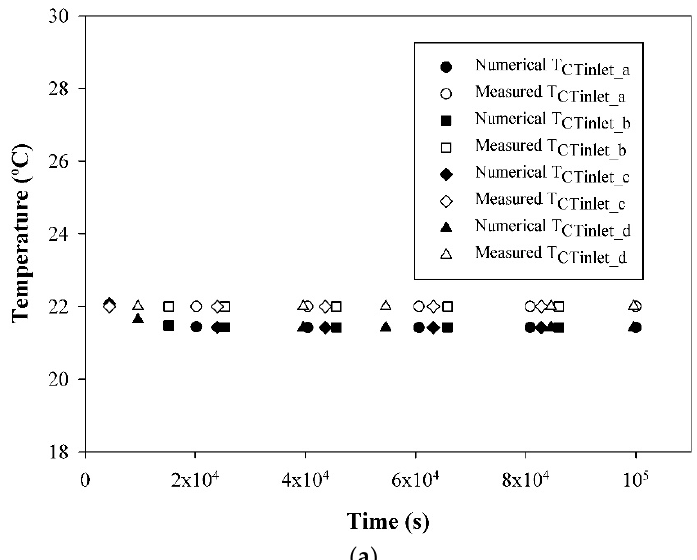
Figure 3. Numerical and measured pump power ( a ) pump group 1, ( b ) pump group 2 and ( c ) pump group